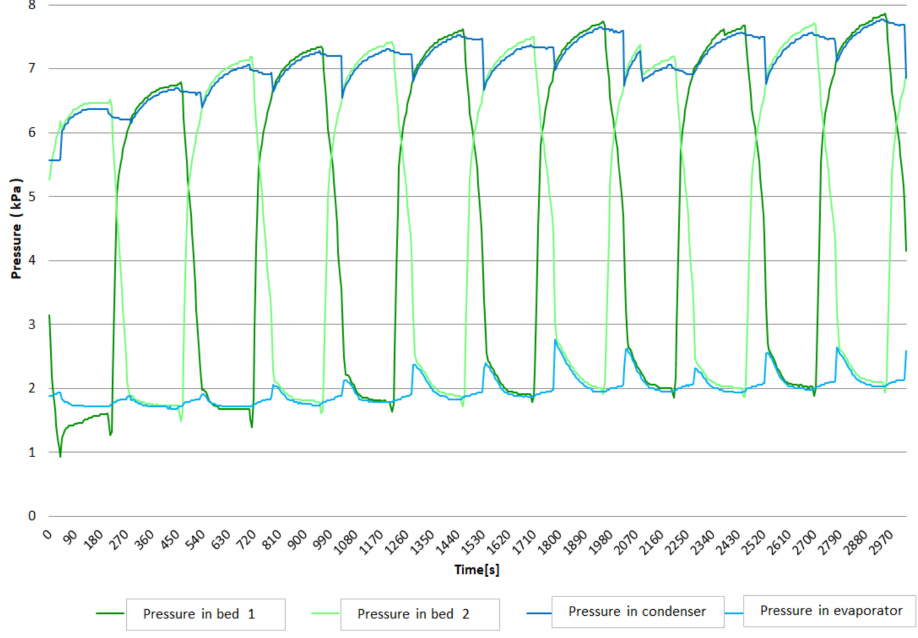
Figure 4. Changes in pressure in the adsorption chiller components during the